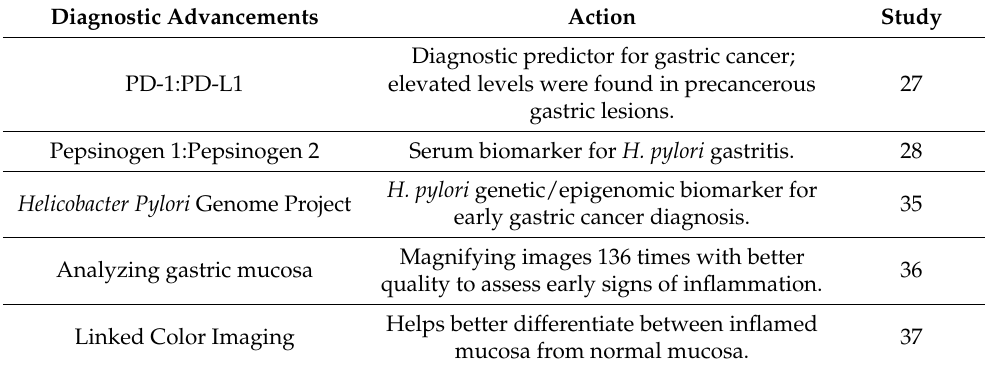
Table 1. Novel diagnostic modalities summarized.